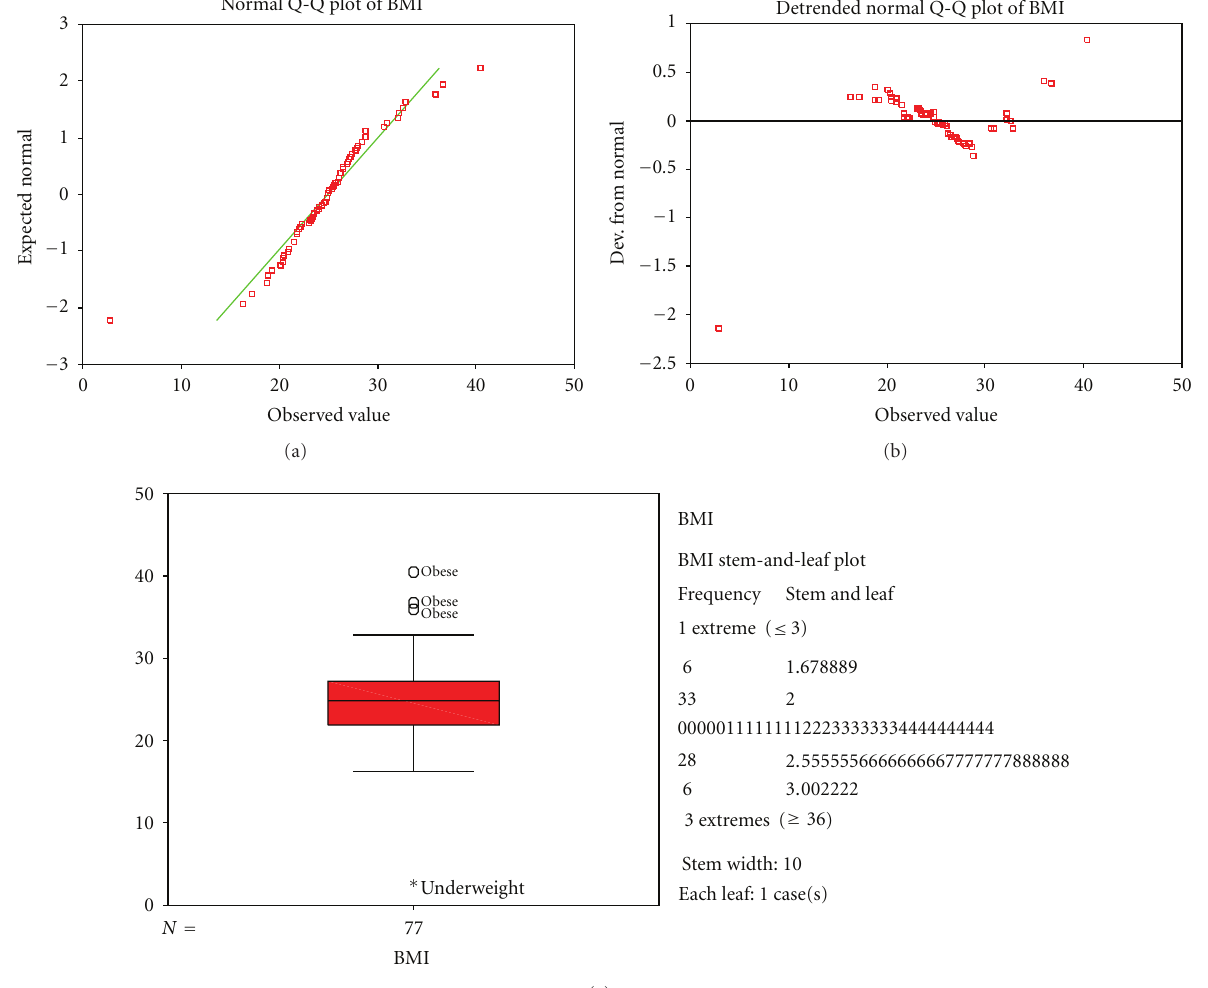
Figure 4: (a) Normal Q-Q plot of BMI, (b) detrended normal Q-Q plot of BMI, and (c) stem-leaf plot of BMI.